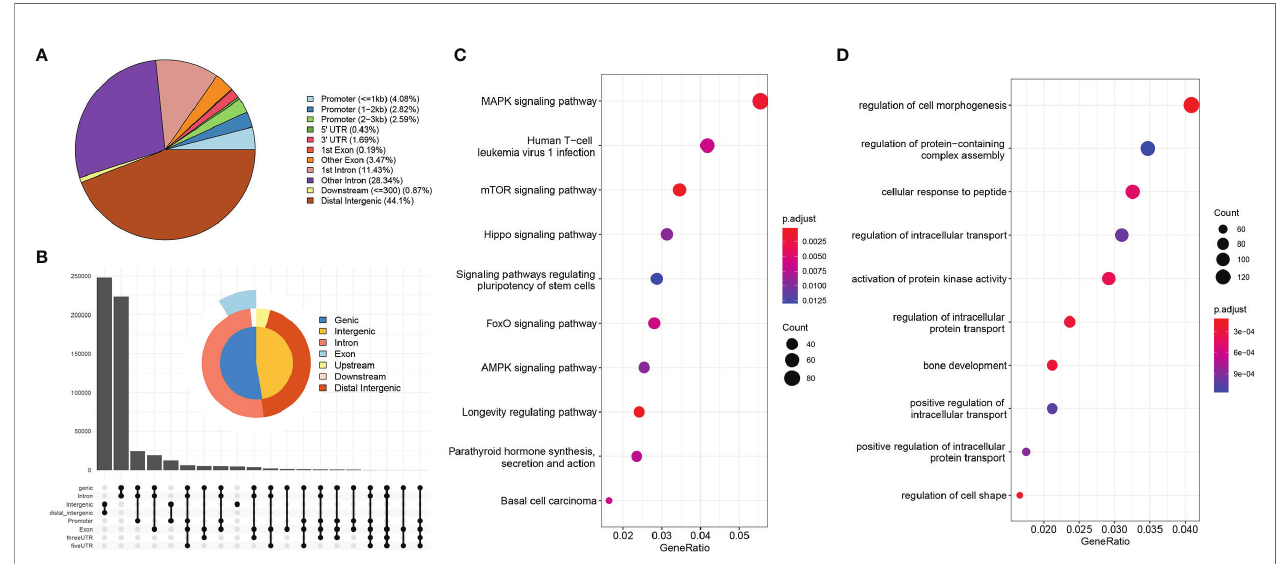
FIGURE 2 | Genome characterization and enrichment analysis. [ (A) location distribution of Peaks on the genome; (B) relative proportions of gene coding regions, intergenic regions, introns, exons, and upstream and downstream regions; (C) KEGG pathway enrichment analysis; (D) GO functional